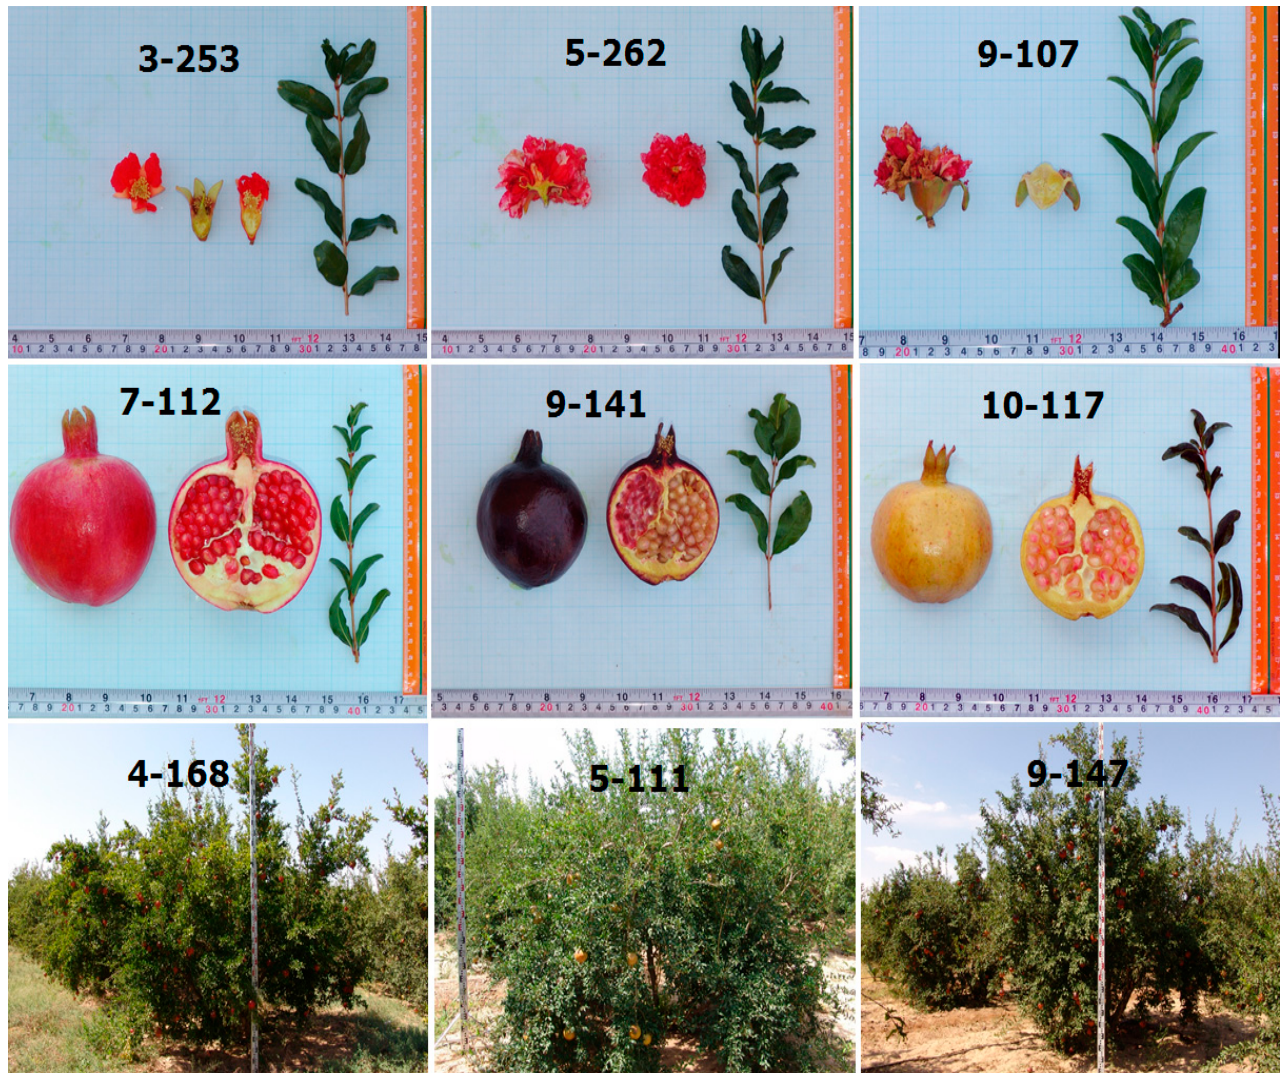
Figure 1. Evaluation of flower, fruit, and tree traits among different Iranian pomegranate genotypes.